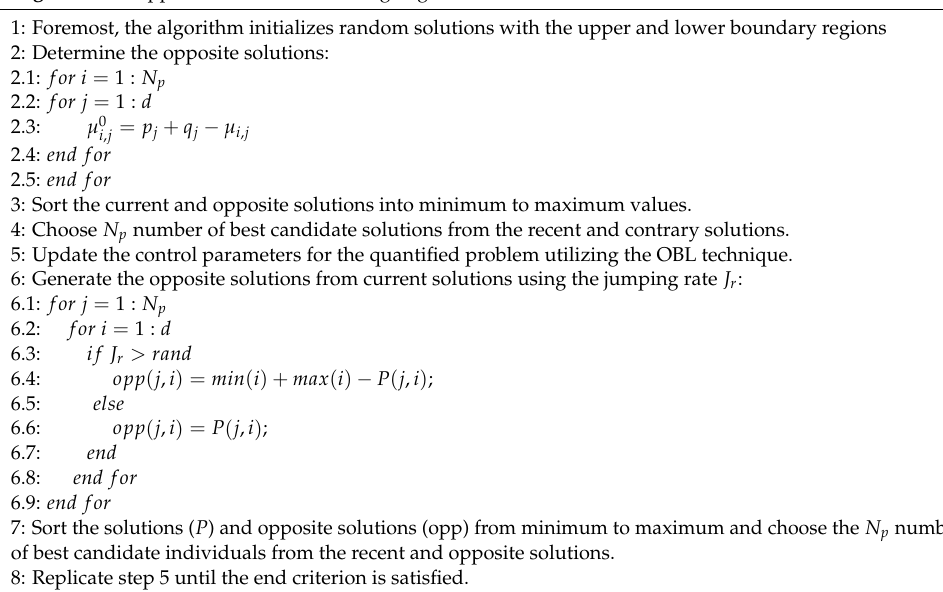
Algorithm 2 . Oppositional-Based Learning